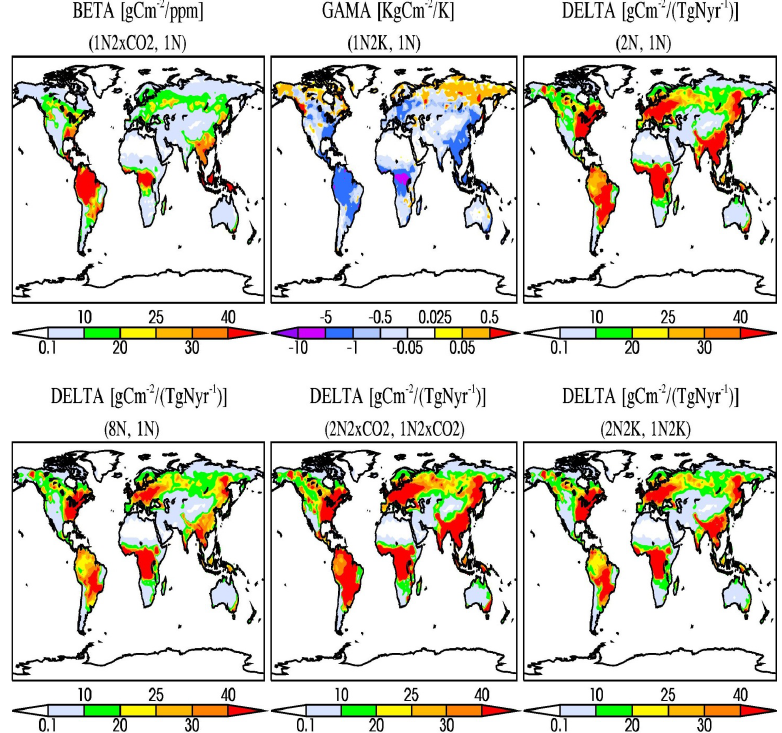
Fig. 8. Spatial pattern of total ecosystem carbon (TEC) sensitivity for CO 2 change ( β L ) , climate change ( γ L ) and N deposition ( δ L ; top panels). The experiments used in the calculation of sensitivity are shown in the parenthesis. The bottom panels illustrate the changes in delta for larger changes in N deposition (general decline), and in the presence of CO 2 fertilization (increase) and climate change